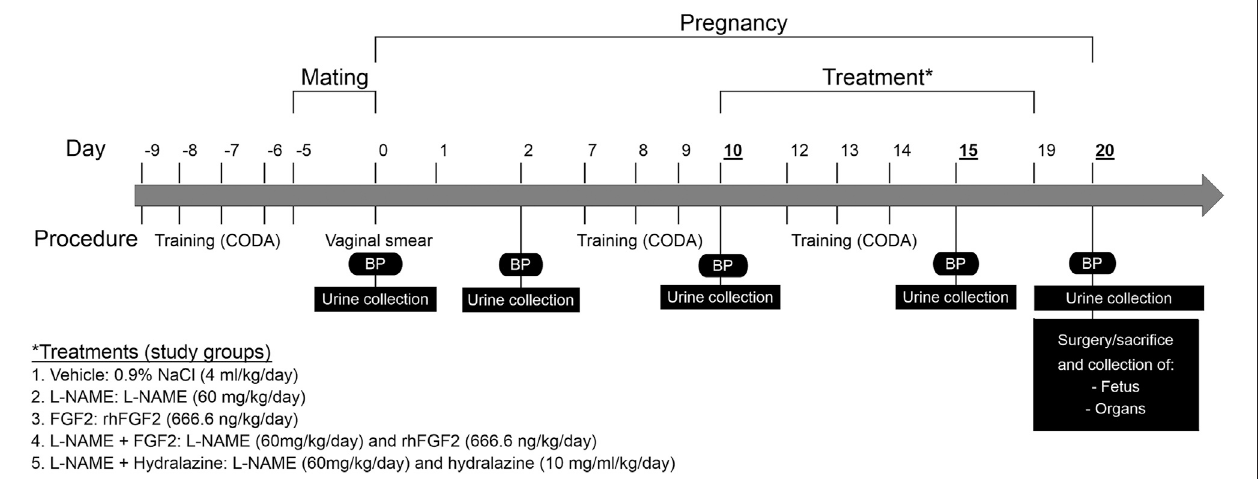
FIGURE 1 | Experimental design of protocol. Schematization of the procedures, treatments and study groups included in the protocol over time. BP, Blood pressure; L-NAME, NG-nitro-L-arginine methyl ester; FGF2, fi broblast growth factor 2; rhFGF2, recombinant human